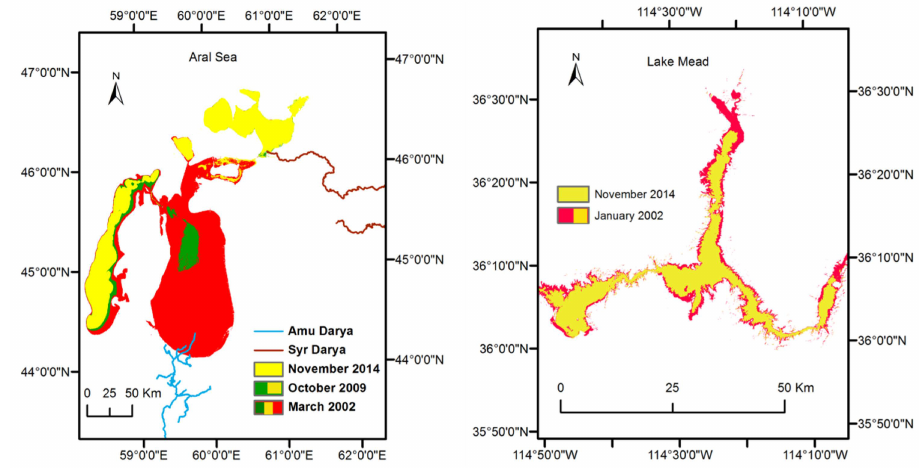
Figure 2. Receding shorelines observed from Landsat. Left : the Aral Sea, and right : Lake Mead.